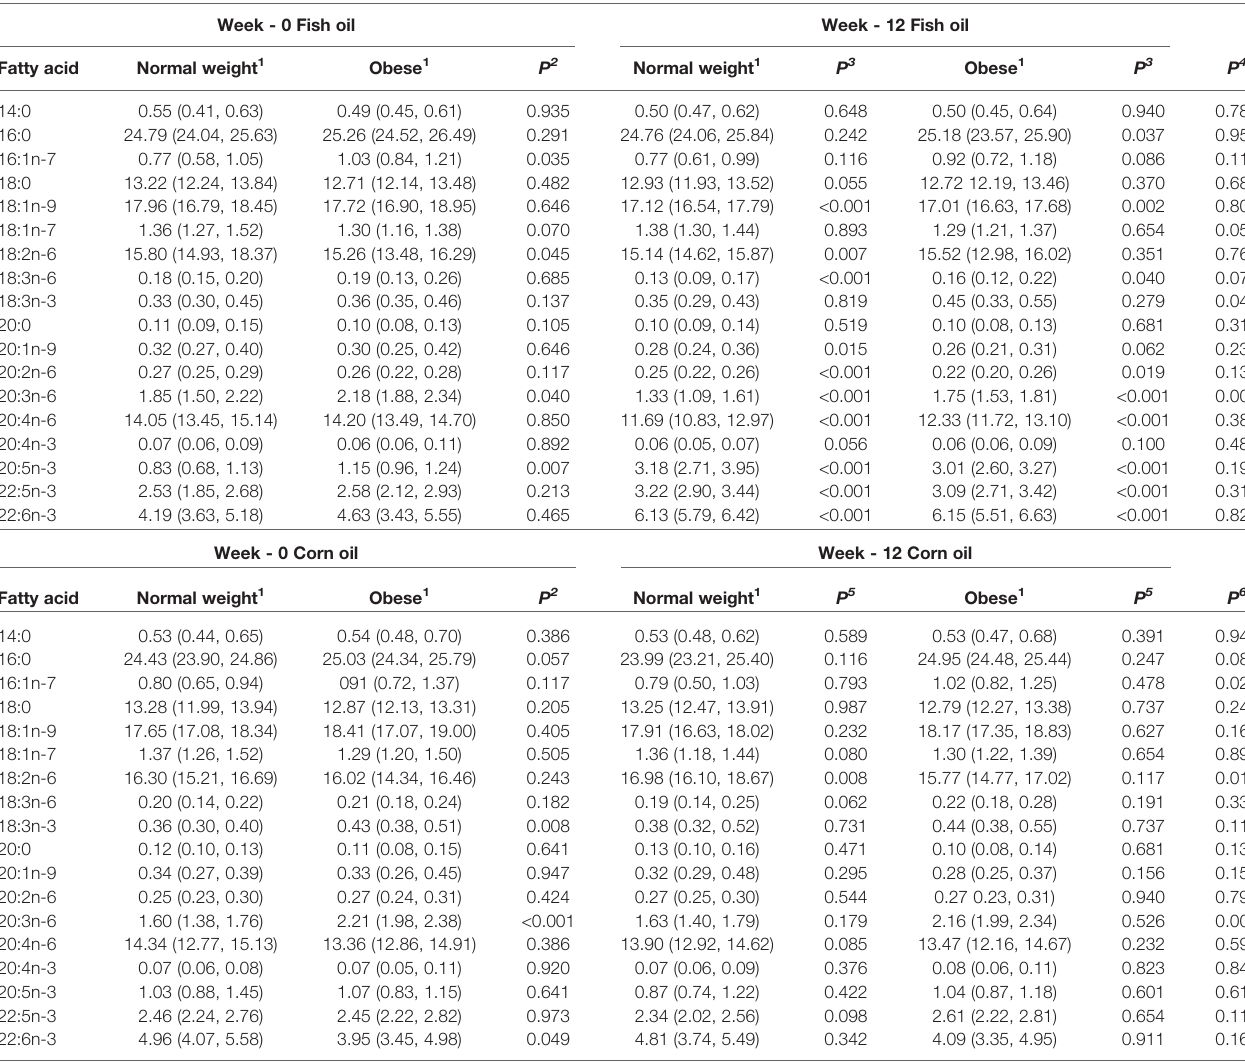
TABLE 5 | Erythrocyte fatty acids at study entry and following 12-week intervention with LC n-3 PUFAs or corn oil in normal weight and individuals living with obesity. Week - 0 Fish oil Week - 12 Fish oil Fatty acid Normal weight 1 Obese